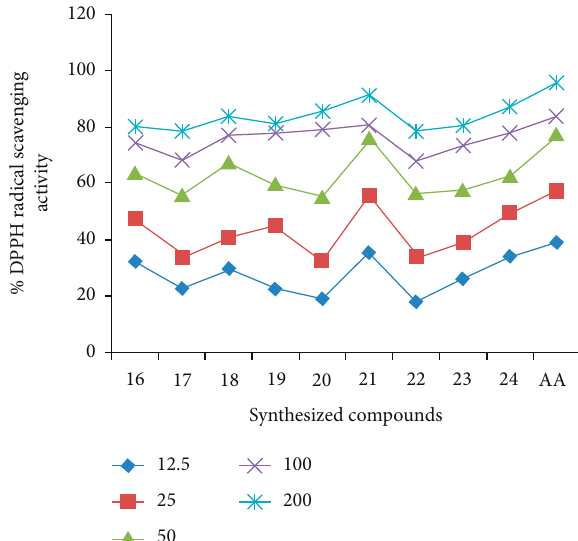
Figure 4: % inhibition of the synthesized compounds (16–24) and the standard drug at different concentration